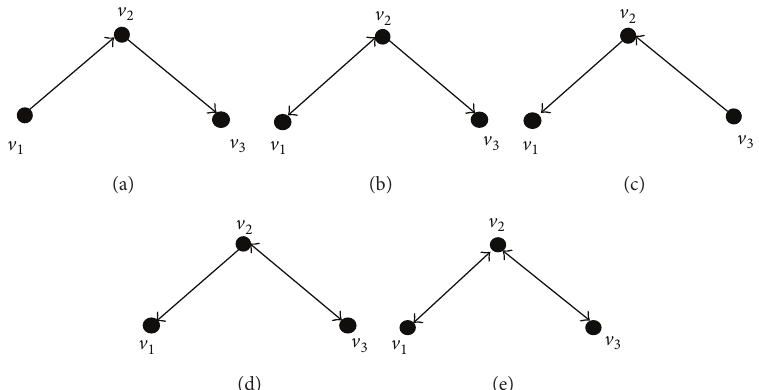
Figure 3: Structural holes of directed fuzzy ternary social network.